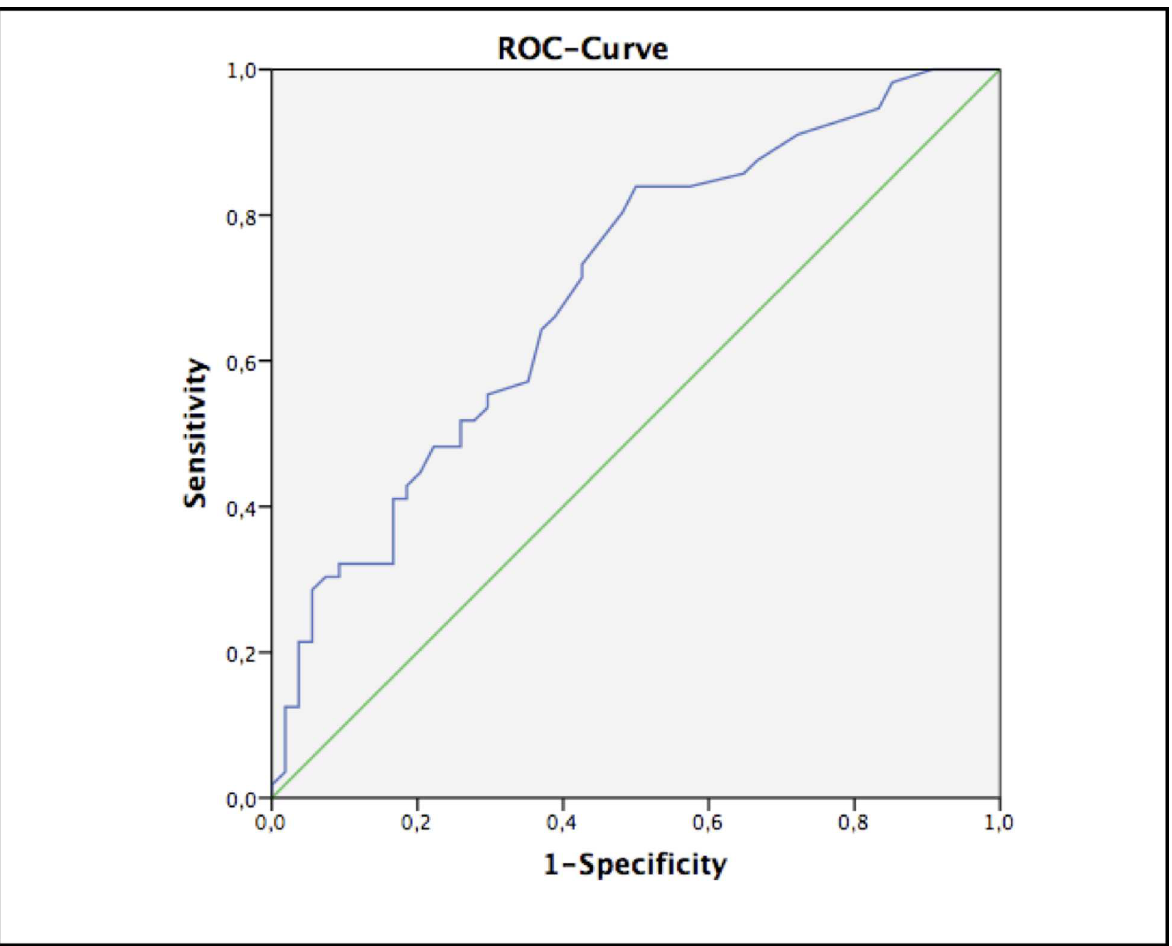
Fig 1. Receiversoperating curve (ROC) for prediction power of lactate value with AUC of